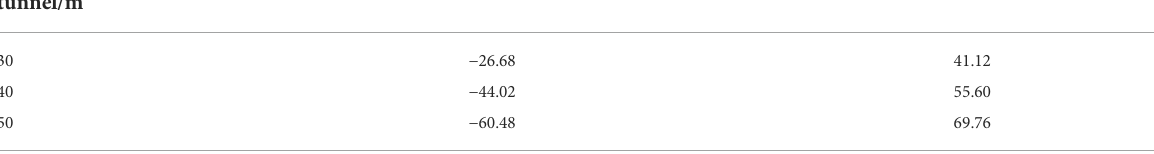
TABLE 4 Tunnel arch top settlement and bottom heaving. Buried depth of the tunnel/m